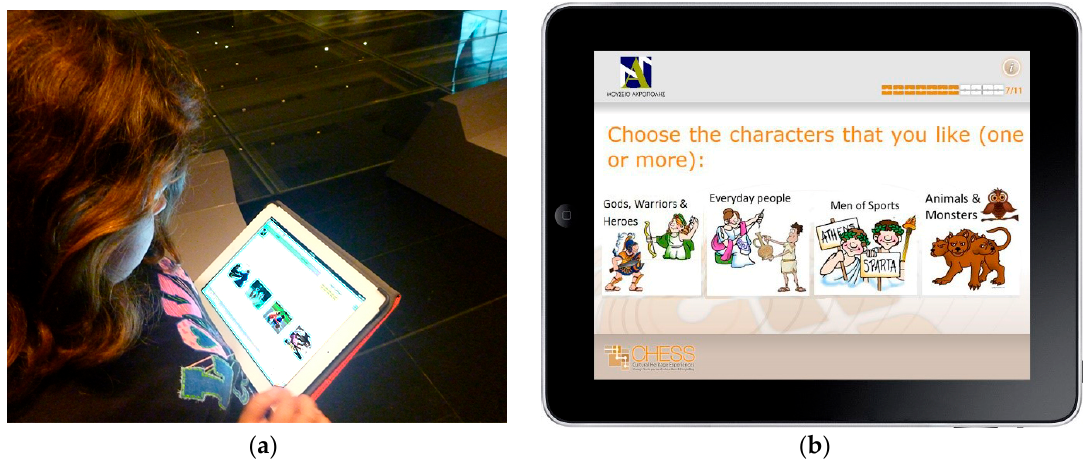
Figure 3. ( a ) A young visitor completing the CHESS Visitor Quiz before beginning her museum experience; ( b ) one of the questions of the quiz used for user profiling/persona